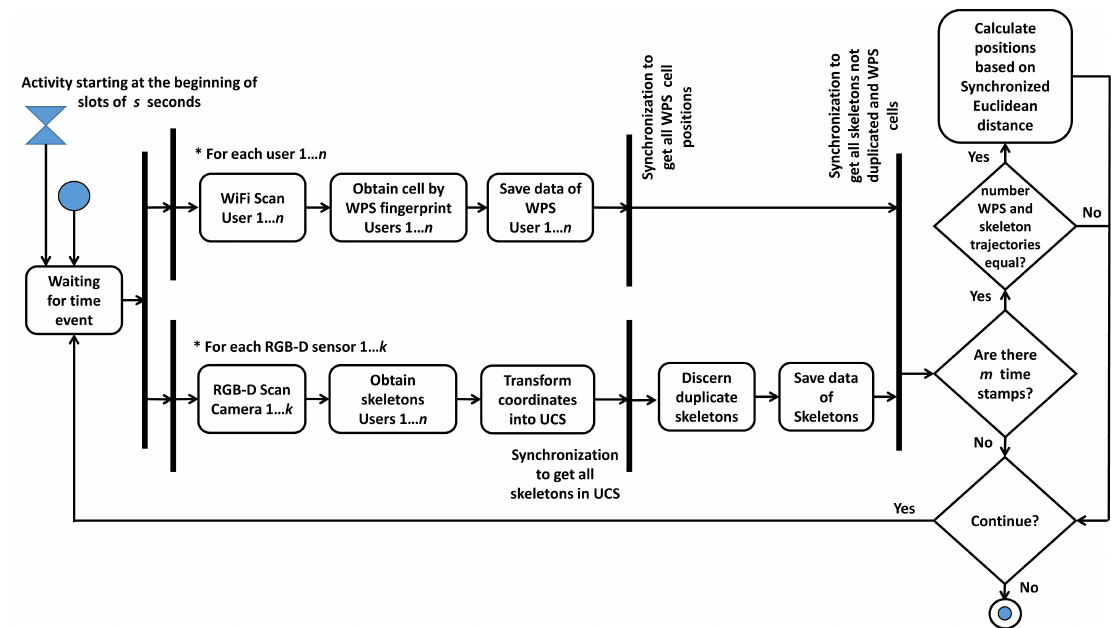
Figure 3. Activity diagram during the Operational